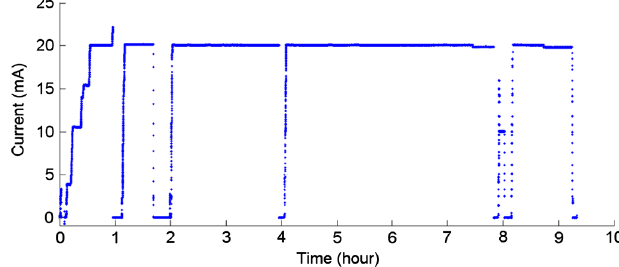
FIG. 4. Current as a function of time for the run in